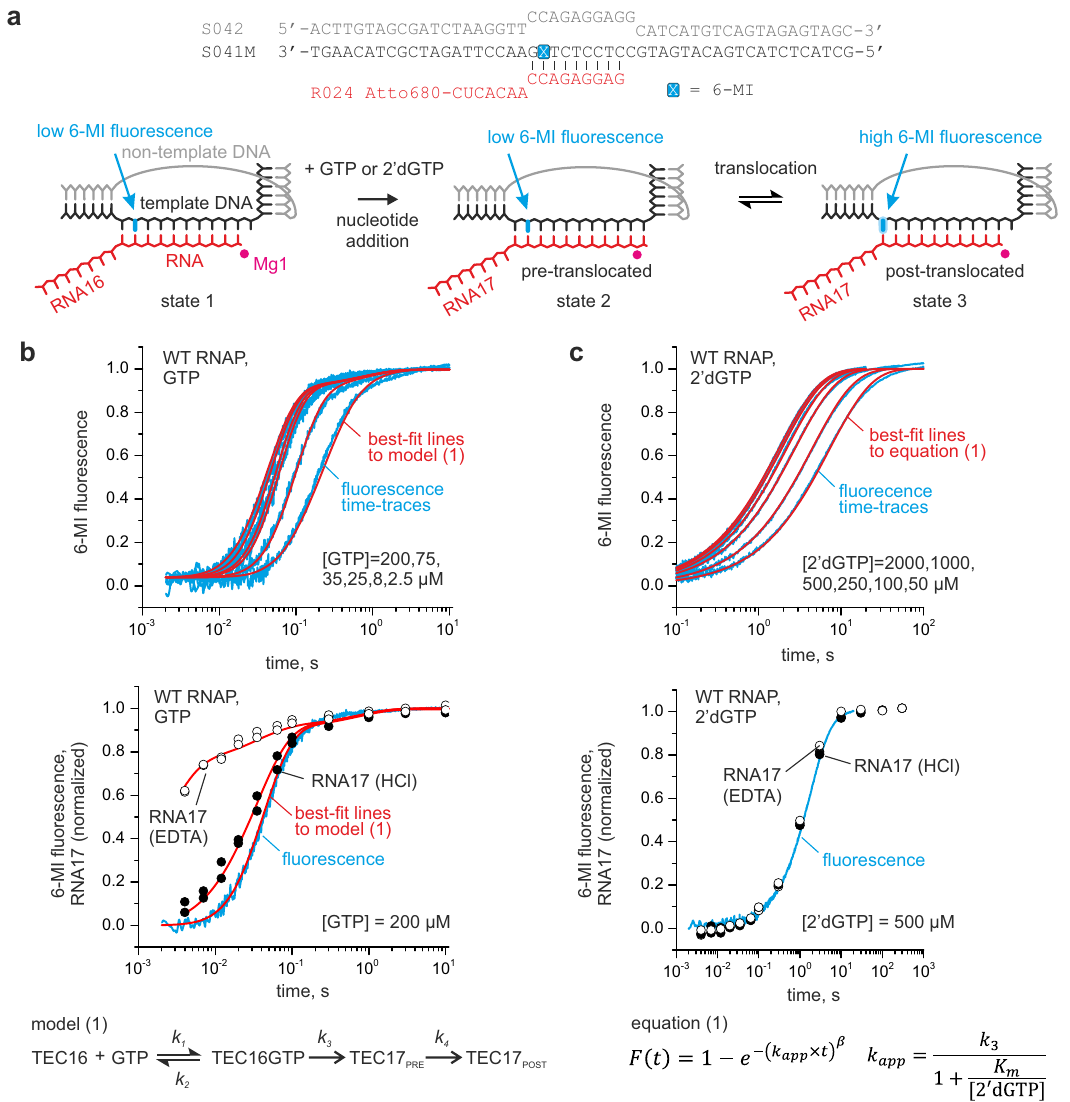
Fig. 2 Time-resolved measurements of GTP and 2 ′ dGTP utilization by the WT E. coli RNAP. a The nucleic acid scaffold employed in translocation and nucleotide addition assays. The fl uorescence of a guanine analog 6-MI (cyan) was quenched by neighboring base pairs in the initial TEC (state 1) and the pre-translocated TEC that formed following the nucleotide incorporation (state 2) but increased when the 6-MI relocated to the edge of the RNA:DNA hybrid upon translocation (state 3). The template DNA, non-template DNA, RNA, and the catalytic Mg 2 + ions are colored black, gray, red, and magenta, respectively. b GTP concentration series. The data were fi t to model (1). c 2 ′ dGTP concentration series. The data were fi t to equation (1). The best- fi t lines and fl uorescence time-traces are colored red and cyan, respectively. The HCl and EDTA quenched data points are shown as closed and opened circles, respectively. All experiments were performed in duplicate with similar results, duplicate data were combined for the analysis. Source data are provided as a Source Data fi